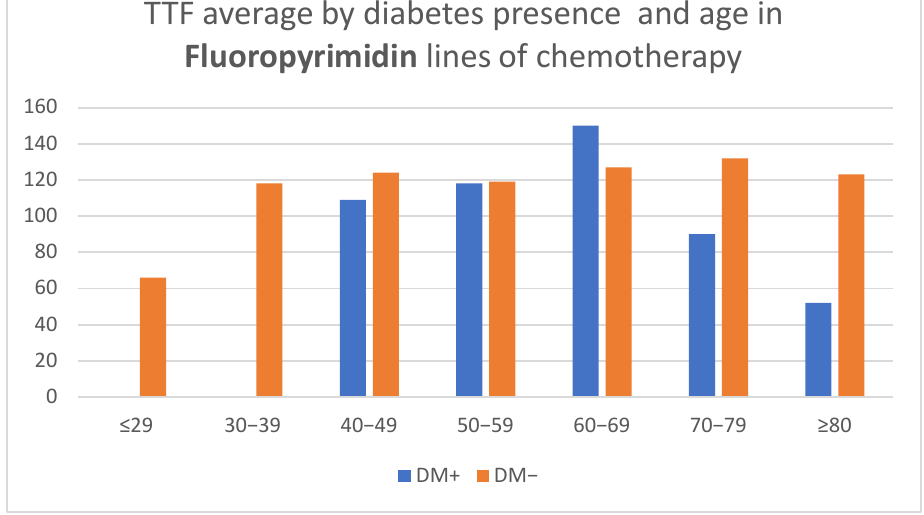
Figure 2. Time to treatment failure (TTF) average by diabetes presence and age in Fluoropyrimidin lines of chemotherapy.